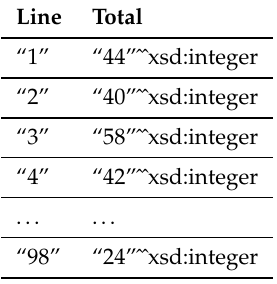
Table 9. Number of stops per